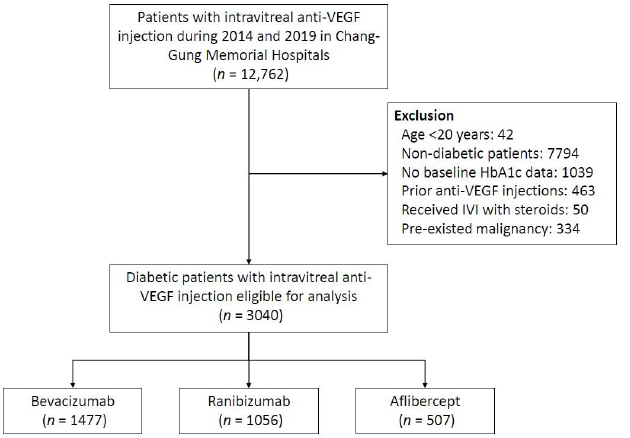
Figure 1. Flowchart of study cohort assembly. Anti-VEGF—anti-vascular endothelial growth factor; HbA1C—glycated hemoglobin; IVI—intravitreal injection.